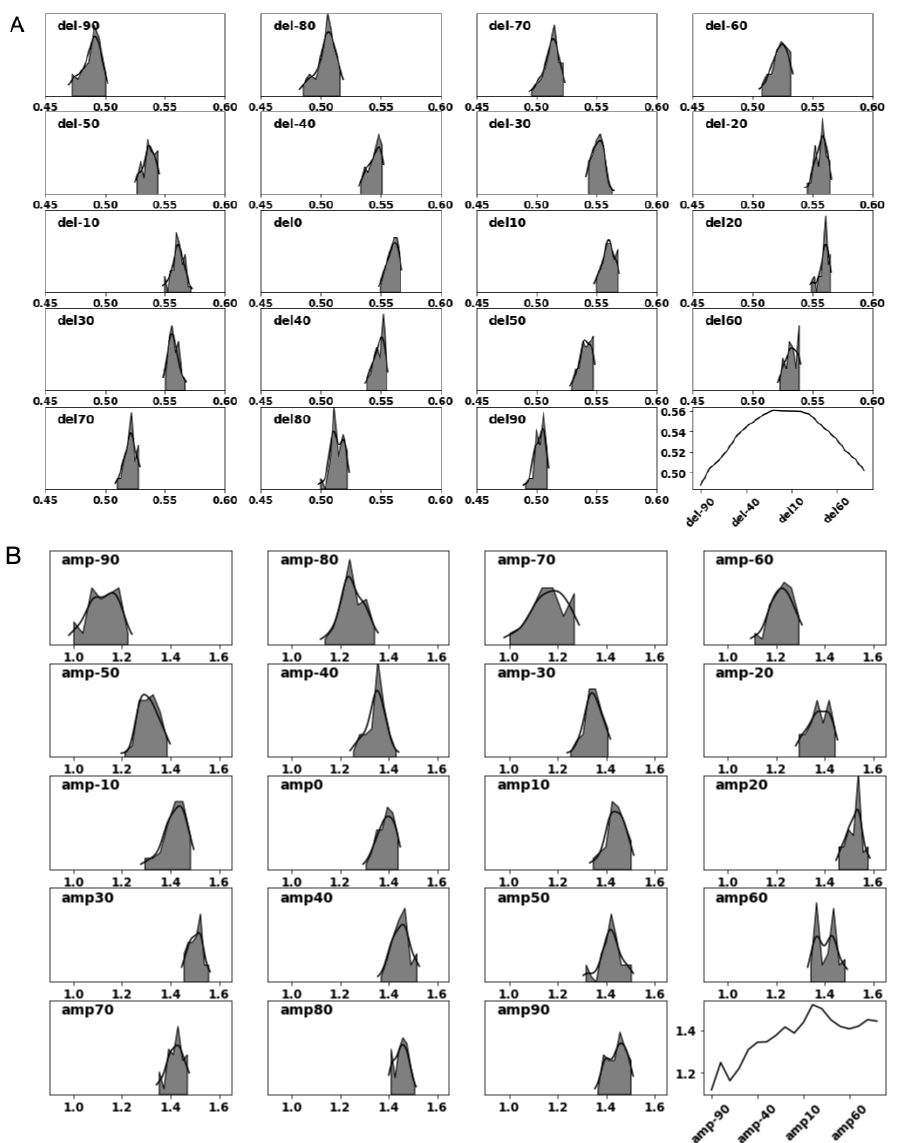
Figure 5. Distribution of the ultrasound time-of-flight ( A , del/ τ ) and amplitude ( B , amp/ a ) signal when the model eye is oriented to gaze angle θ = φ = 0